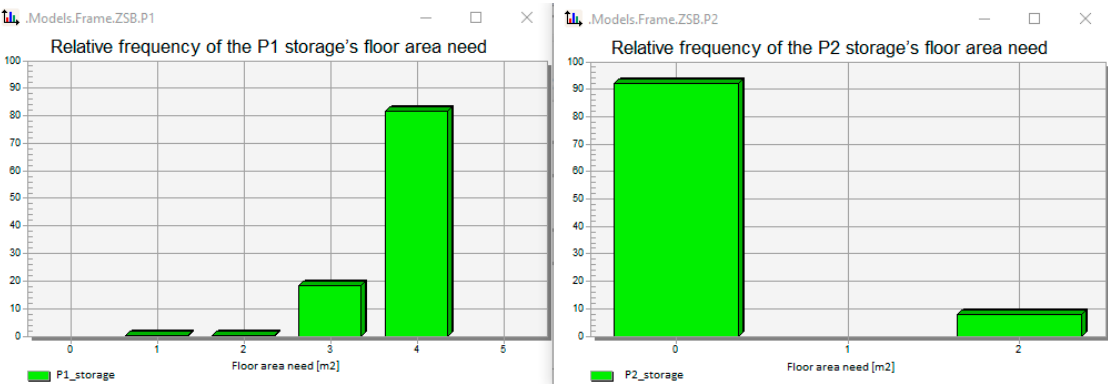
Figure 6. Relative frequency of storage’s floor area needs.